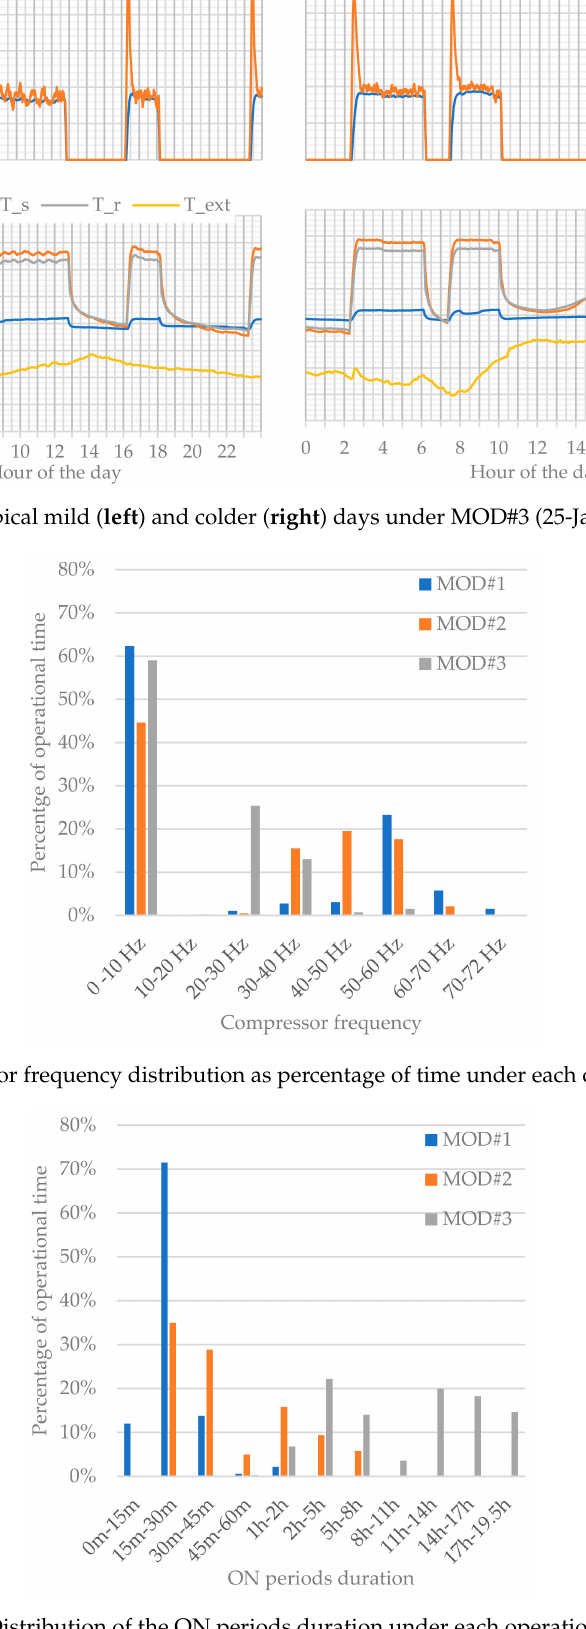
Figure 10. Distribution of the ON periods duration under each operational